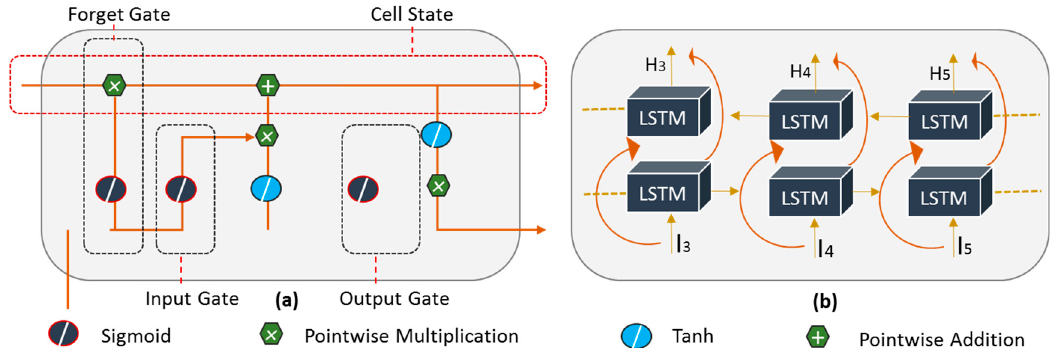
Figure 3. ( a ) Internal architecture of LSTM, comprising of multiple gates along with LSTM cells for stimulation of numerous operations, permitting the gates to store and omit related information; ( b ) MBD-LSTM, which acquires input data sequences and then proceeds in a forward and backward direction.